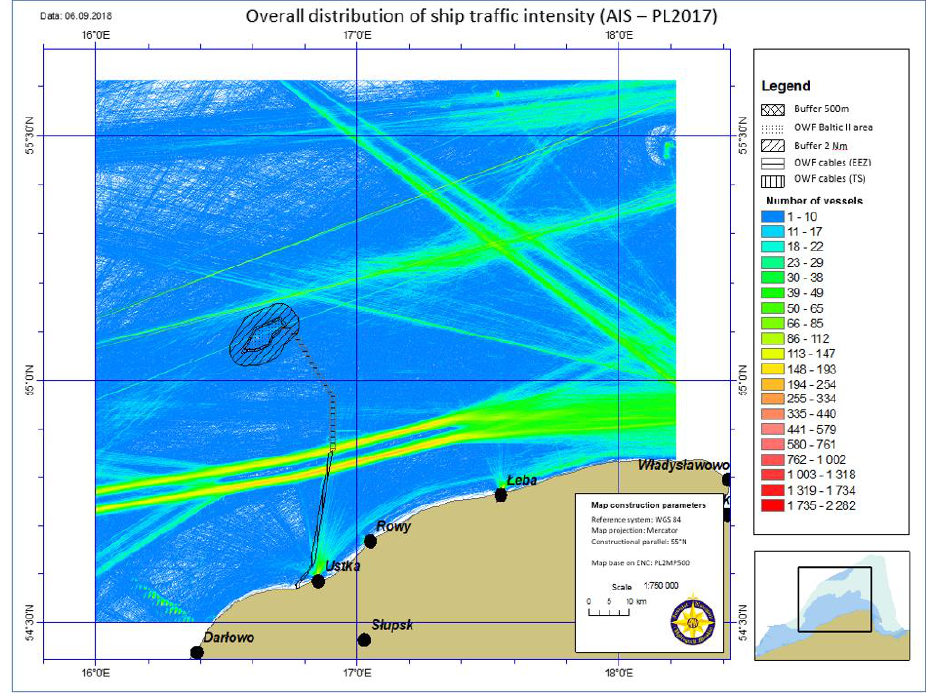
Figure 4. Distribution of traffic intensity for all types of ships covering a large sea area surrounding OWF AIS-PL 2017. Table 2. Qualitative characteristics of all types of ships.